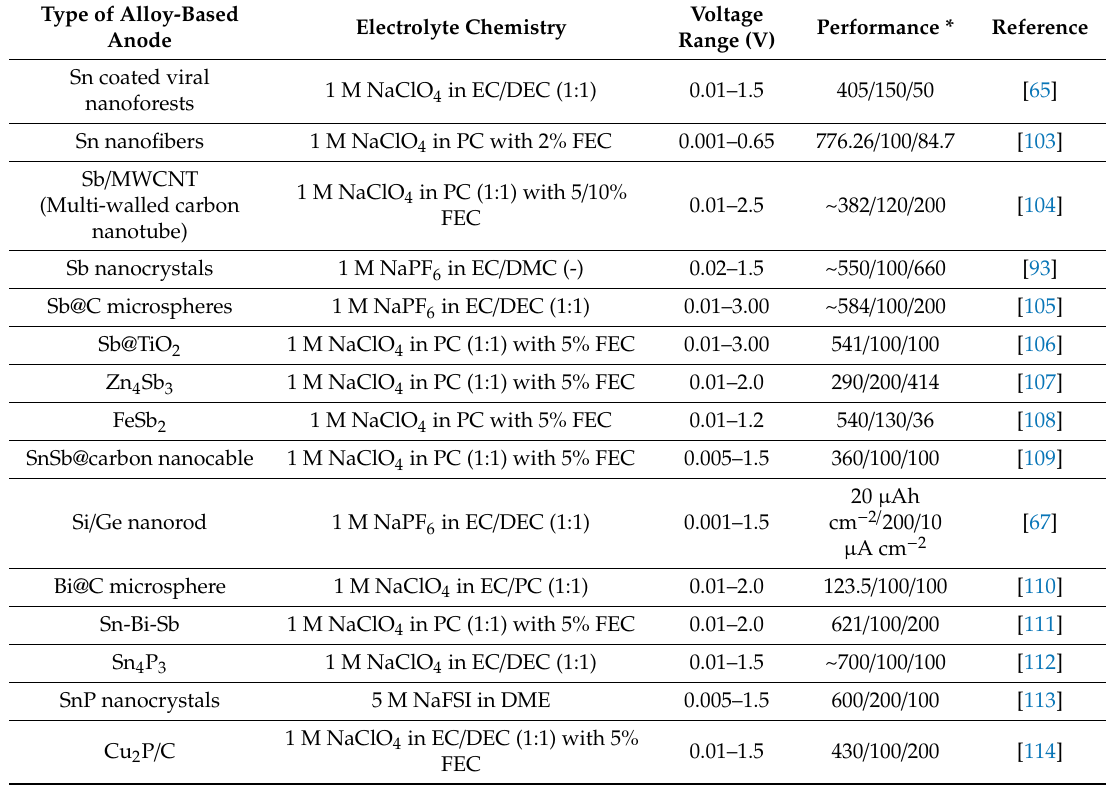
Table 2. High performance of alloy-based anodes in Na-ion battery